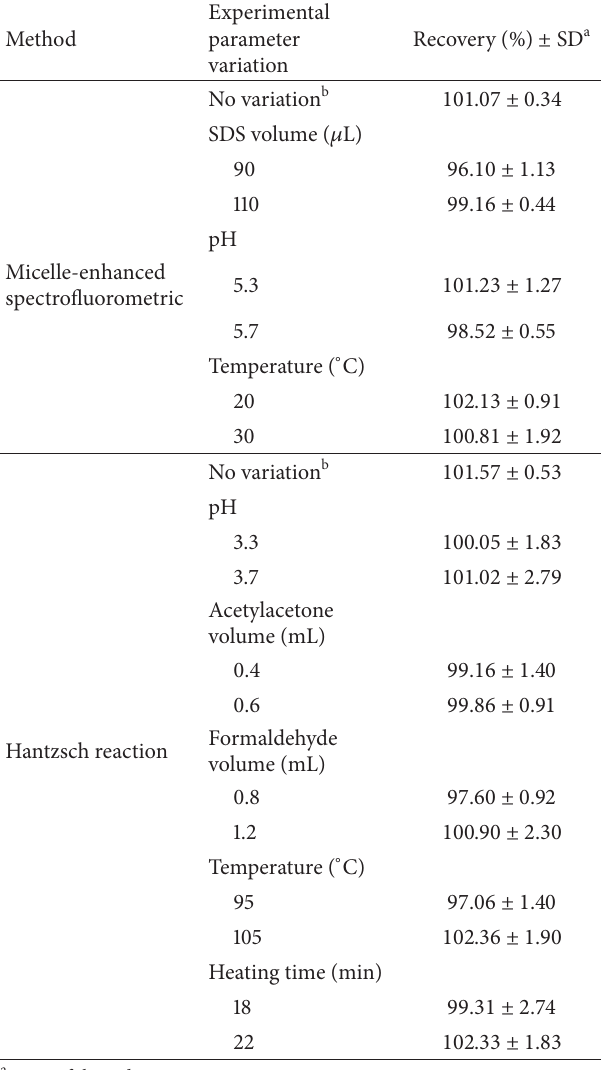
Table 3: Robustness of the proposed